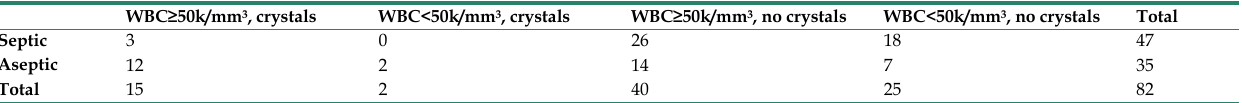
Table 5. Breakdown of the 82 cases that underwent surgical irrigation and debridement with respect to presence of crystals and synovial WBC